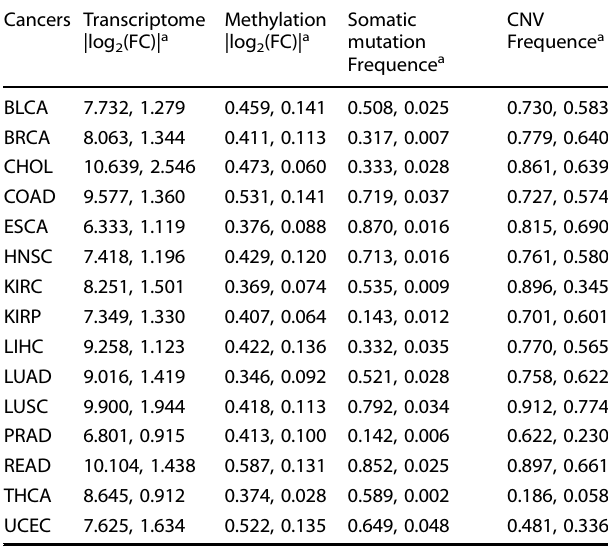
Table 1. Degree of perturbation of the omnigenic neighbourhood in multi-omics